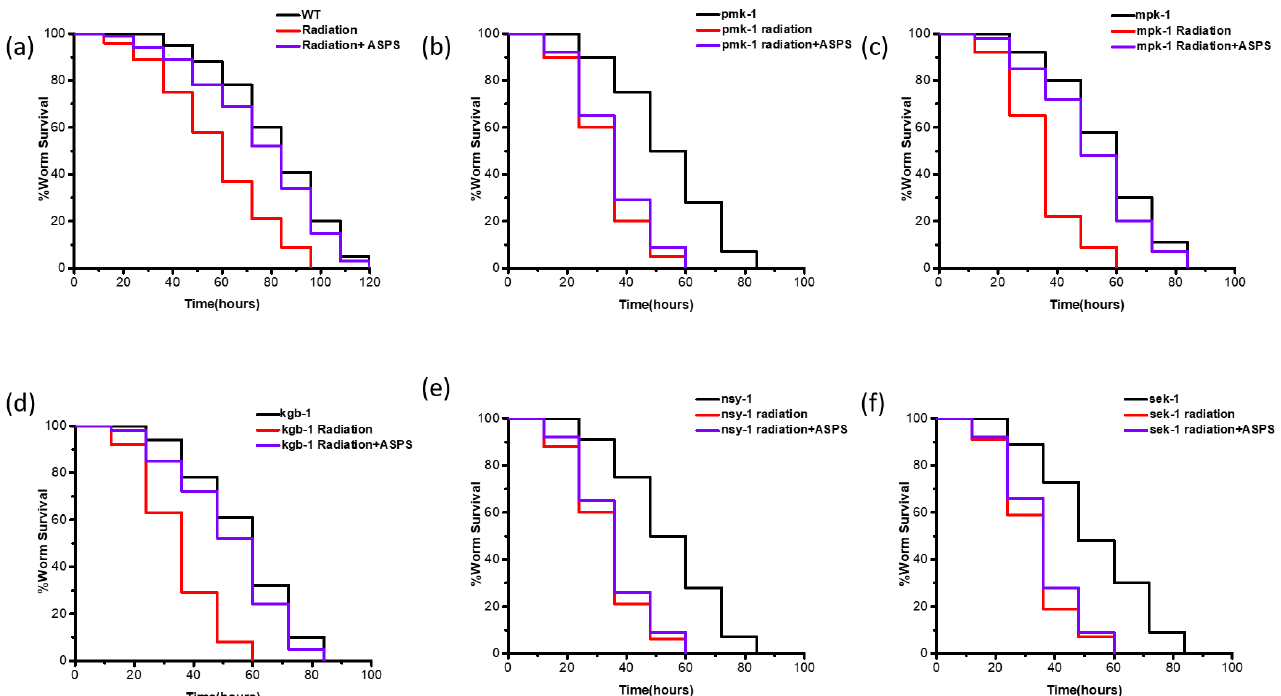
Figure 4. ASPS promoted innate immunity through p38 MAPK pathway. ( a – f ) Survival curve of PA14-infected mutants relating to immune signaling pathway. Mutants of core components in the p38 signaling pathway ( nsy-1 sek-1 pmk-1 ) failed to increase survival rate after adding ASPS. n = 3. (log-rank test).